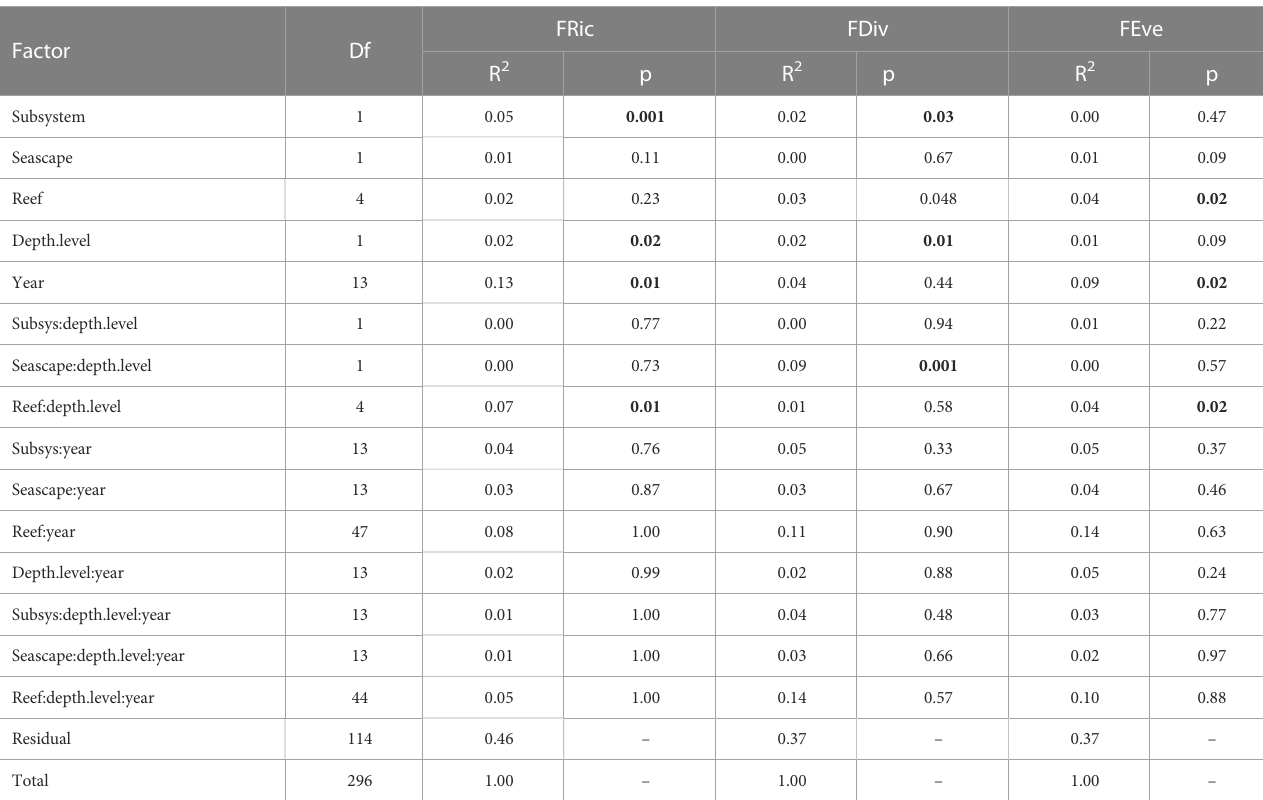
Bold highlight signi fi cant differences at a =